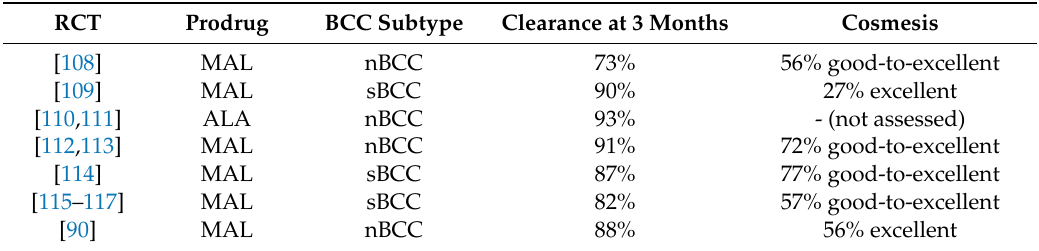
Table 2. Outcomes of topical PDT treatments of BCC from randomized control trials